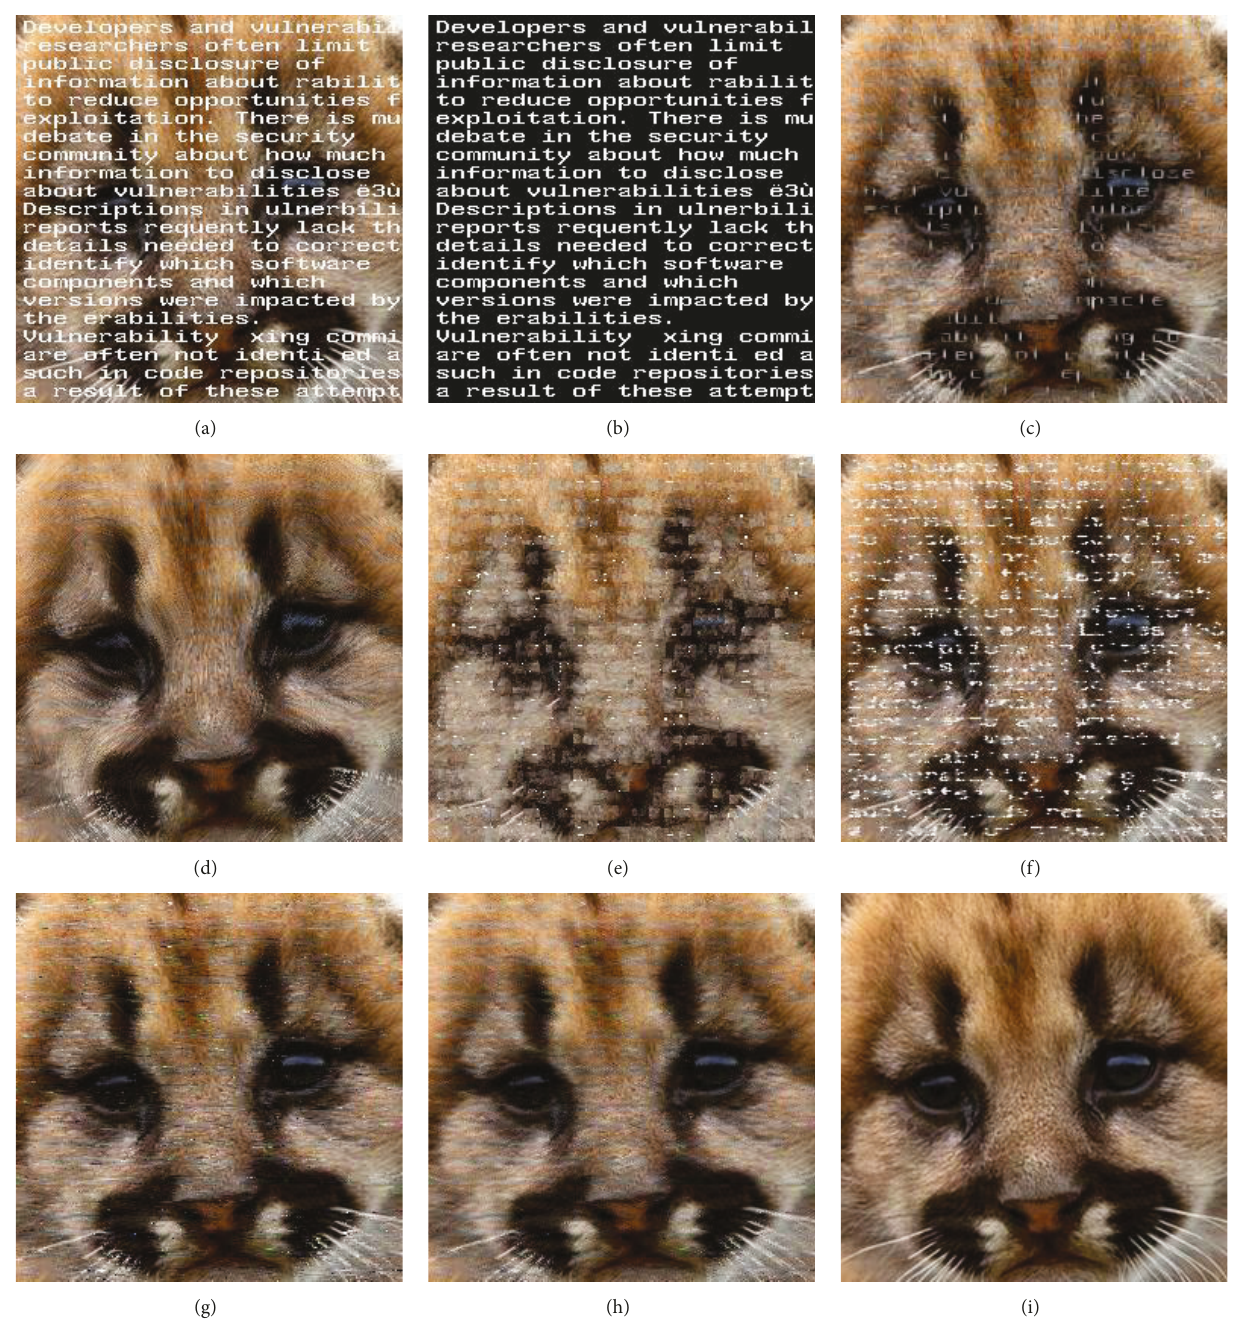
Figure 11: Repaired raccoon images by different inpainting methods. (a) The damaged image; (b) the mask image; (c) by BSCB; (d) by CT; (e) by EB; (f) by TV; (g) by Thiele; (h) by our method; (i) the original